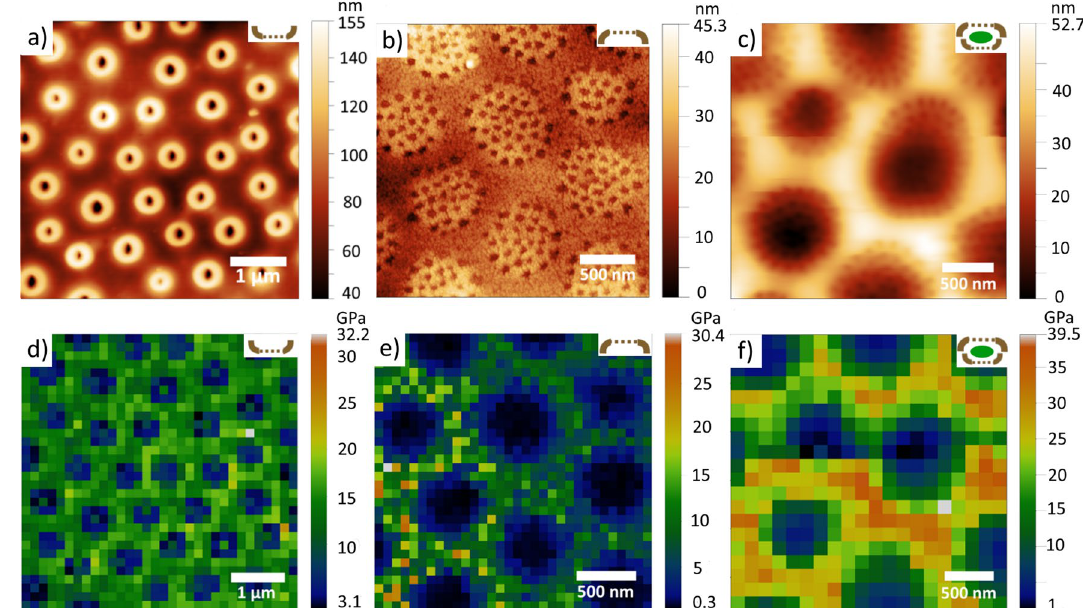
Figure 3. AFM study of cleaned frustules and wet diatom cells. Topography of a measured: ( a ) inner side and ( b ) outer side of cleaned frustule, ( c ) wet diatom cell. Young’s modulus of: ( d ) inner and ( e ) outer surface of cleaned frustule, ( f ) wet diatom cell.